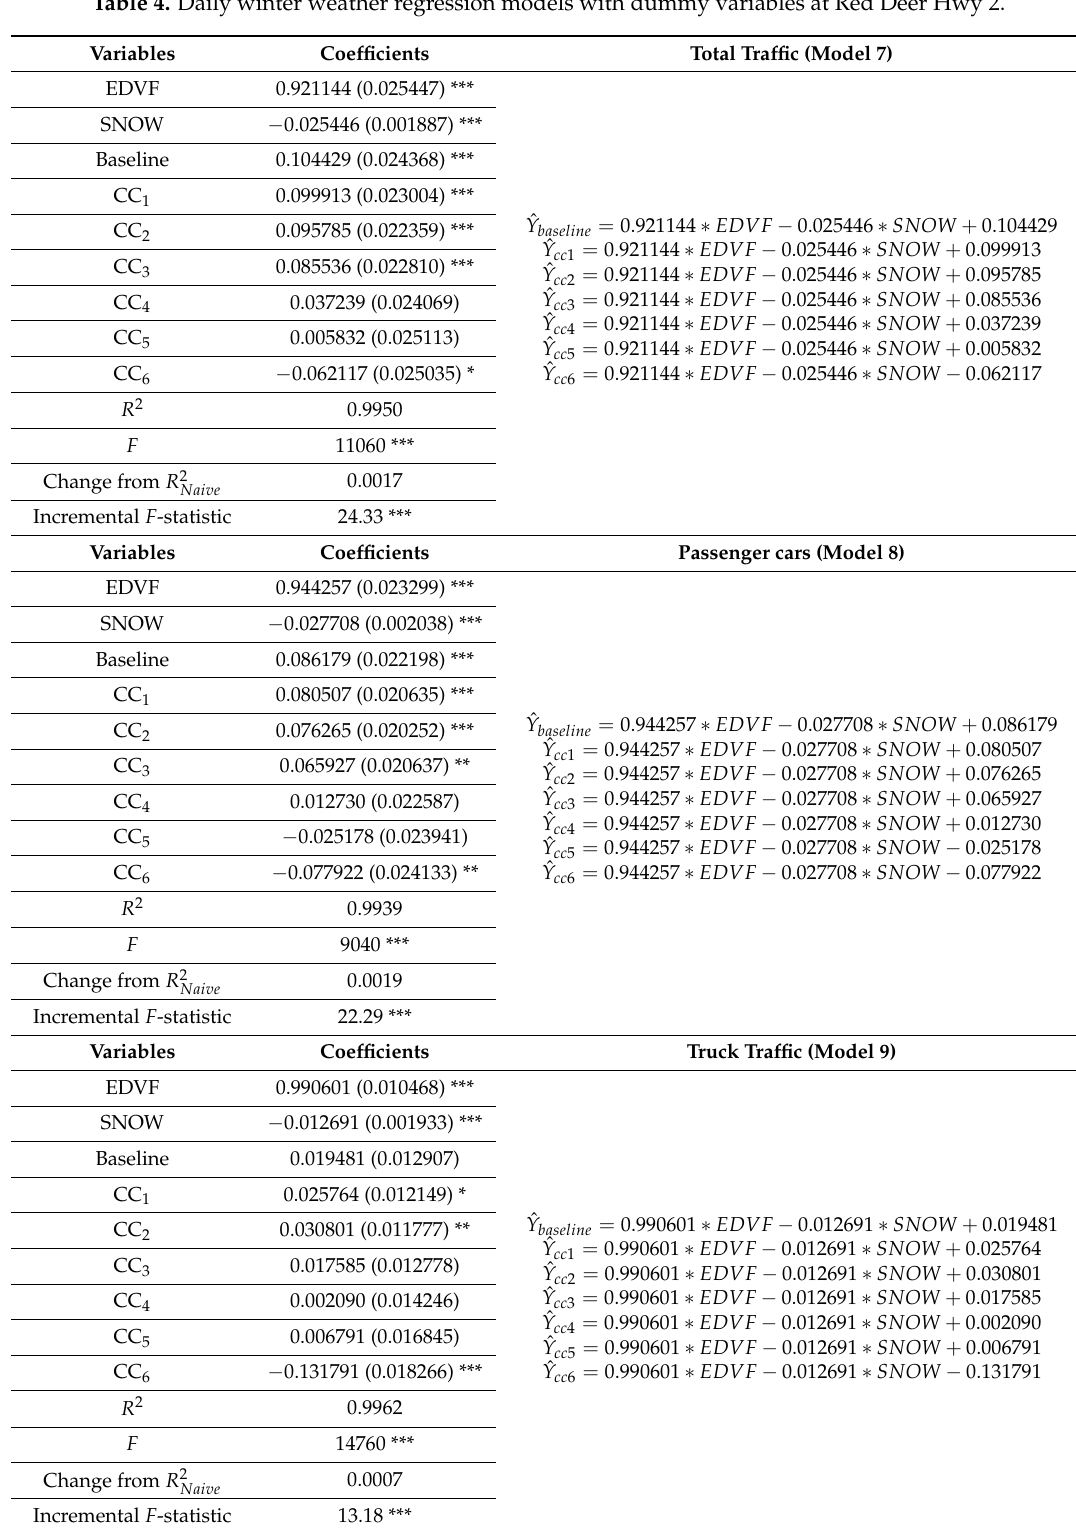
Table 4. Daily winter weather regression models with dummy variables at Red Deer Hwy